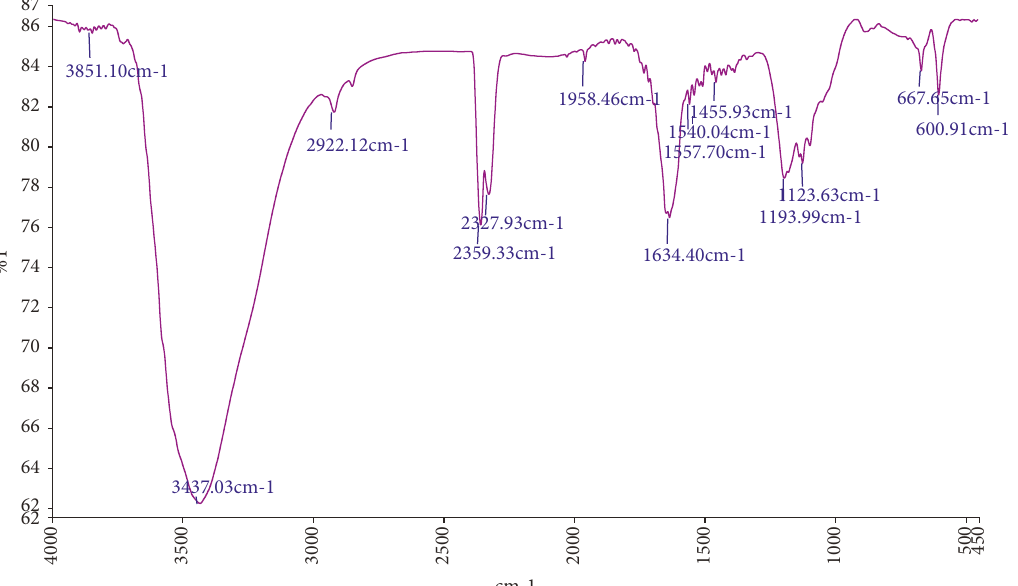
Figure 3: FTIR of the spectrum of green synthesized silver nanoparticles by M. oleifera leaves